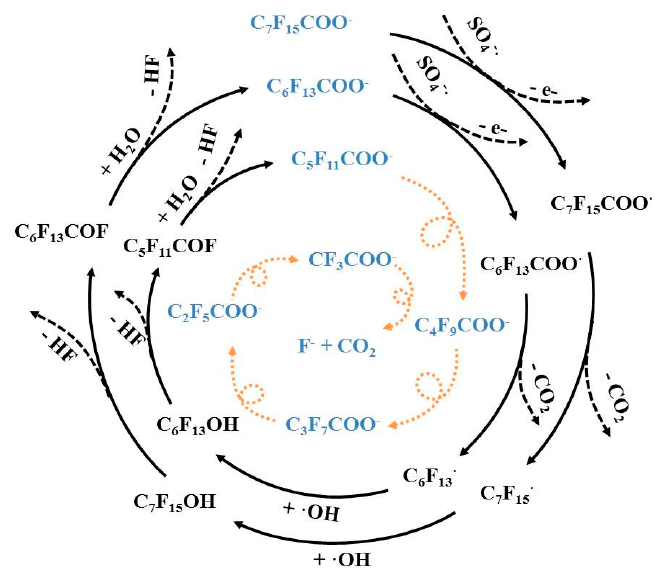
Figure 6. Schematic pathway for PFOA degradation (mainly pathway).